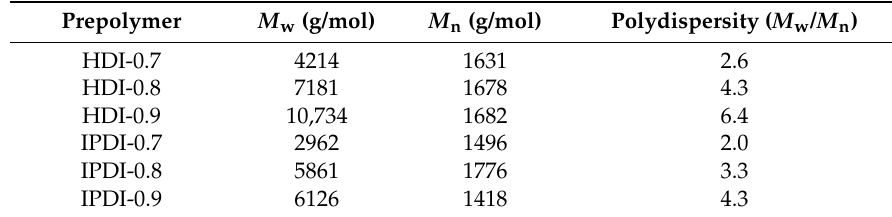
Table 1. Molecular weight parameters of COOH-containing prepolymers synthesized using different isocyanates and NCO/OH mole